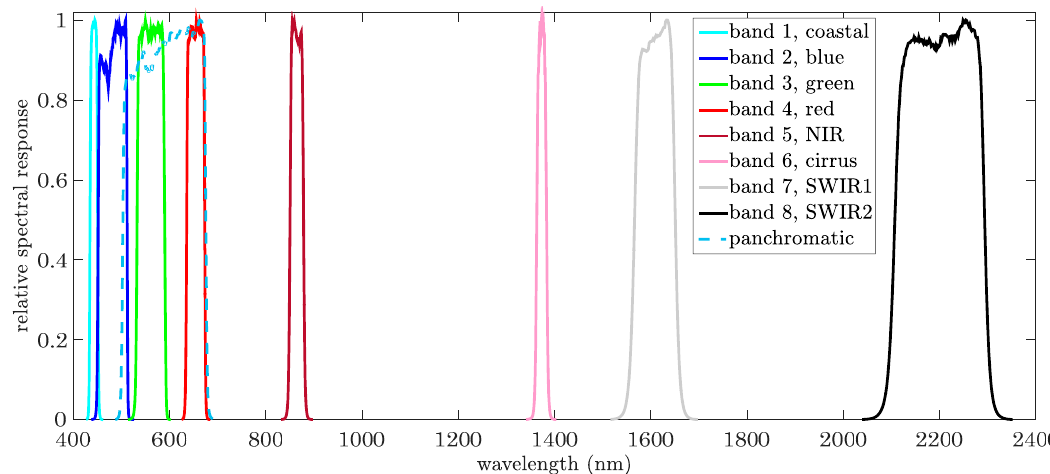
Figure 1. The spectral responses of the Landsat 8 multispectral and panchromatic sensors.